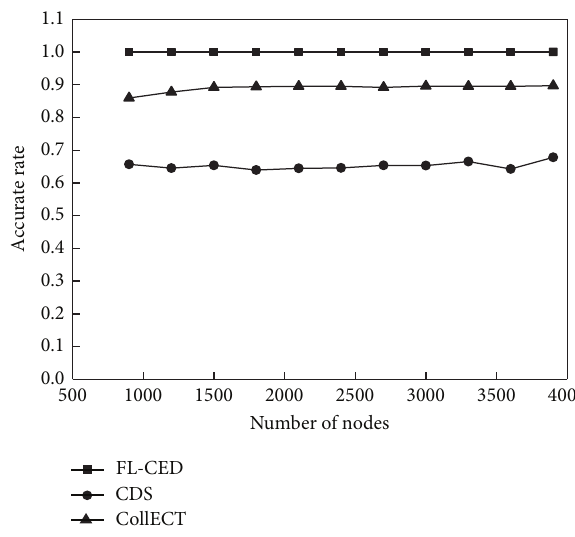
Figure 8: Number of active nodes.